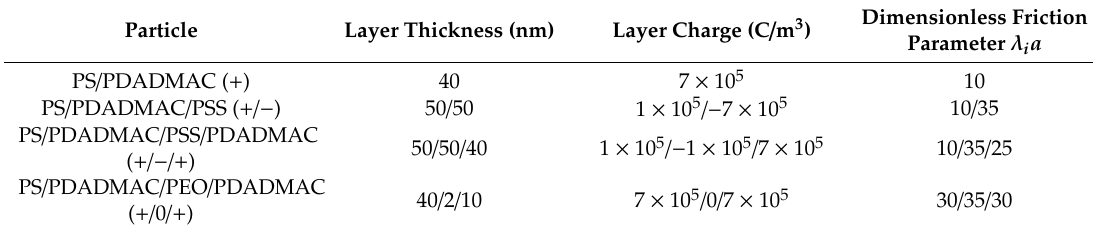
Figure 10. Top: real part of the dynamic mobility of bare and PDADMAC-coated (“ + ” in the plot) latex particles as a function of the field frequency; bottom: dielectric increment (dielectric constant relative to that of the solvent) for the same systems; inset: theoretical predictions using the parameters in Table 2. The symbols are experimental data, and the lines are fittings obtained with the model described. Table 2. Best-fit parameters of the model, obtained from experimental mobility data.